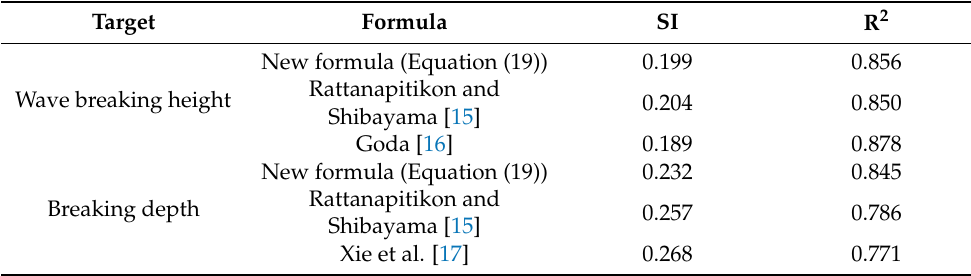
Table 5. Results of error analysis for the new formula.